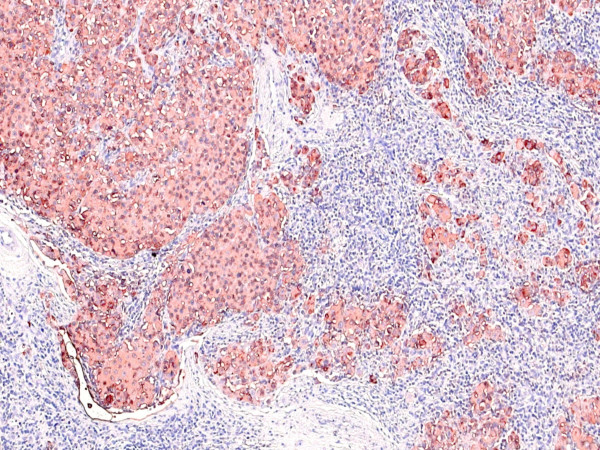
Lymph node metastasis of patient MAZ immunostained with mAb SM5-1. Immunohistochemical staining of a lymph node metastasis of patient MAZ.